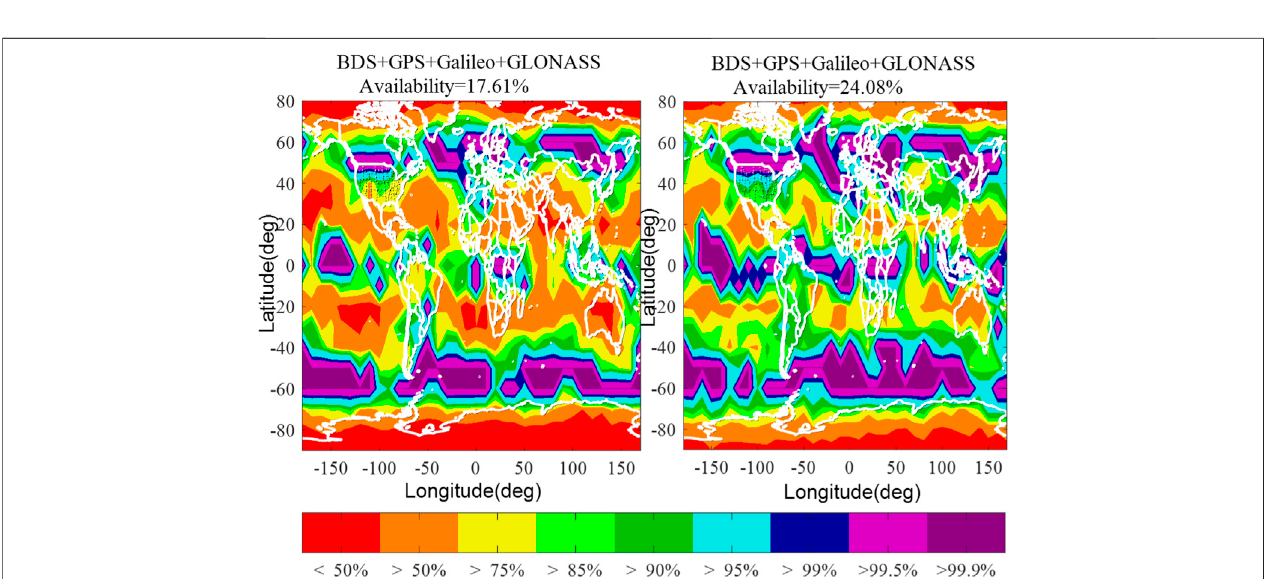
FIGURE 9 | Availability before and after four-constellation optimization under the condition of VAL = 20 m.